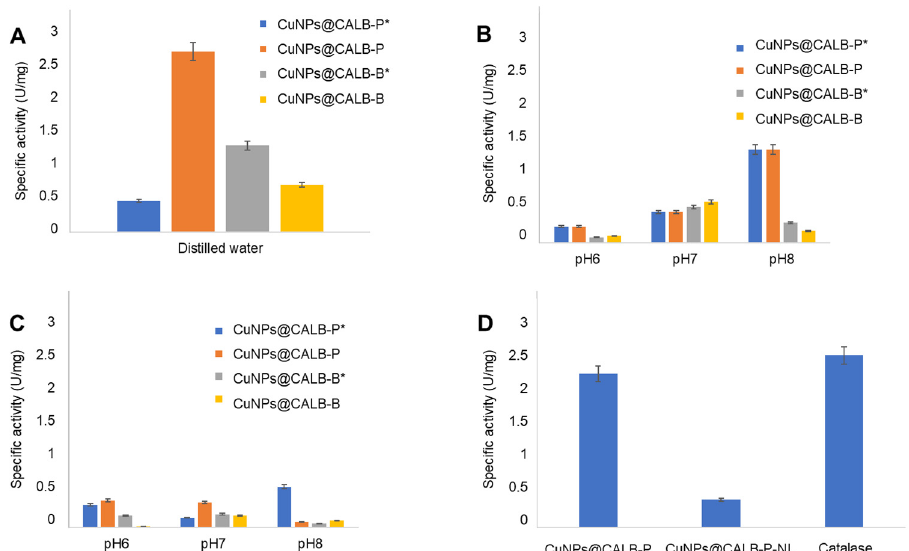
Figure 6. Catalase-like activity of different CuNPs@CALB hybrids. ( A ) Distilled water; ( B ) sodium phosphate buffer 5 mM; ( C ) sodium phosphate buffer 100 mM; ( D ) CuNPs@CALB-P in distilled water compared with free catalase and CuNPs@CALB-P-NL .